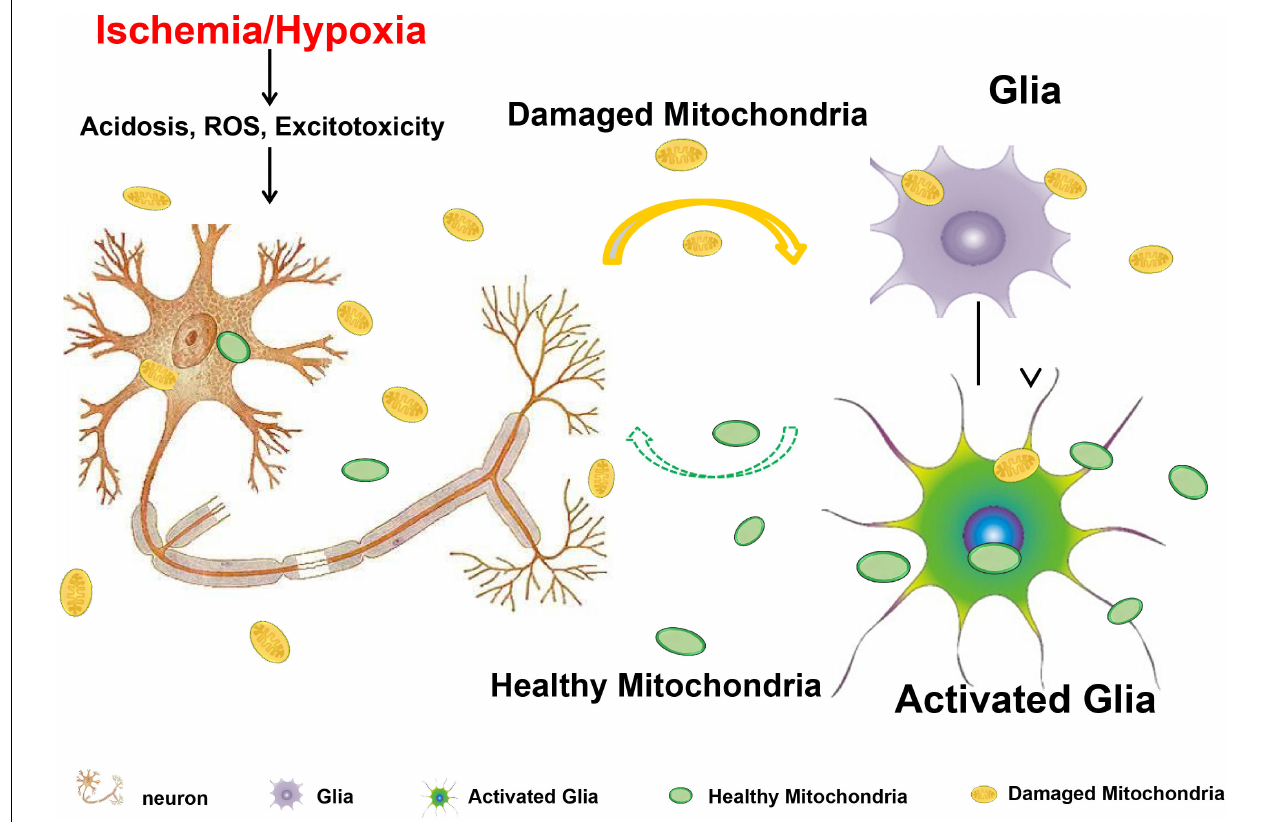
FIGURE 8 | Acidosis, oxidative stress, and excitotoxicity are closely associated with mitochondrial dysfunction and are the major culprits that contribute to the ischemic neuronal death after stroke. When neurons are confronting with these harmful challenges, they might release the defective mitochondria to act as a “help-me” signaling, and recruit the adjacent astrocytes for energy support by promoting astrocytic mitochondrial biogenesis. Solid arrow indicates the confirmed results from this study, and dashed arrow indicates the assumption from previously published